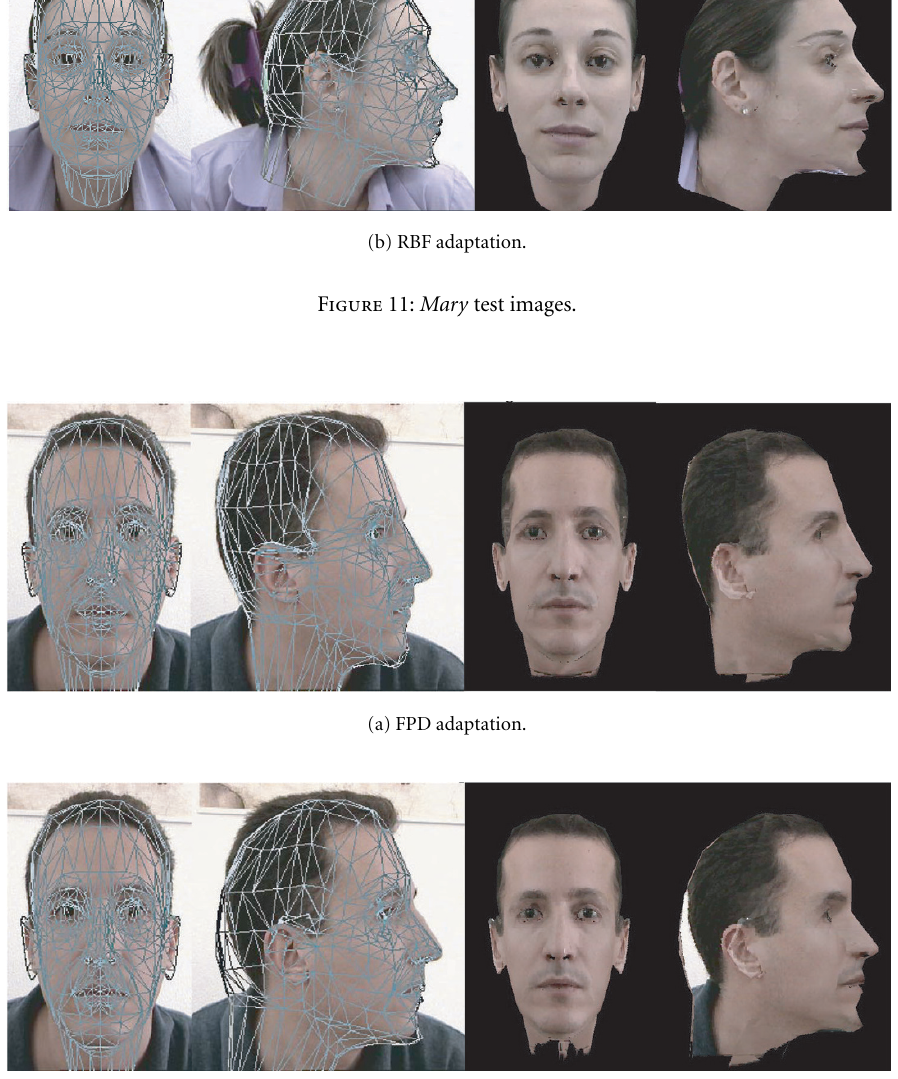
Figure 12: Nikos test